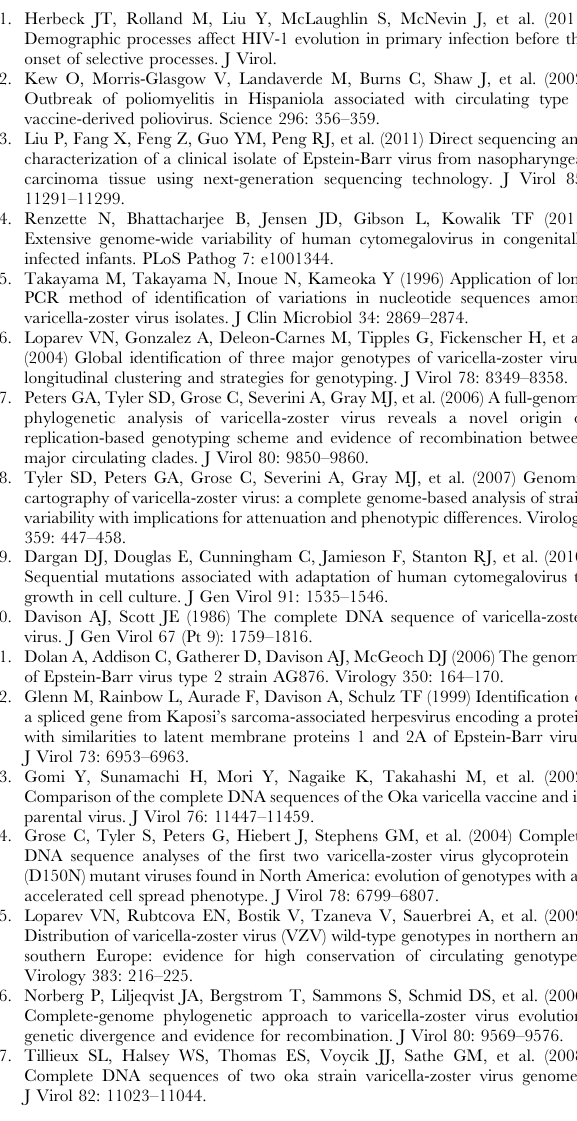
Table S1 Deep sequencing of clinical samples prepared using the SureSelect Target Enrichment System. Table S2 Confirmation of fixed SNPs identified in assembled consensus sequences. Table S3 Primers used to generate overlapping ampli- cons by long PCR for deep–sequencing of